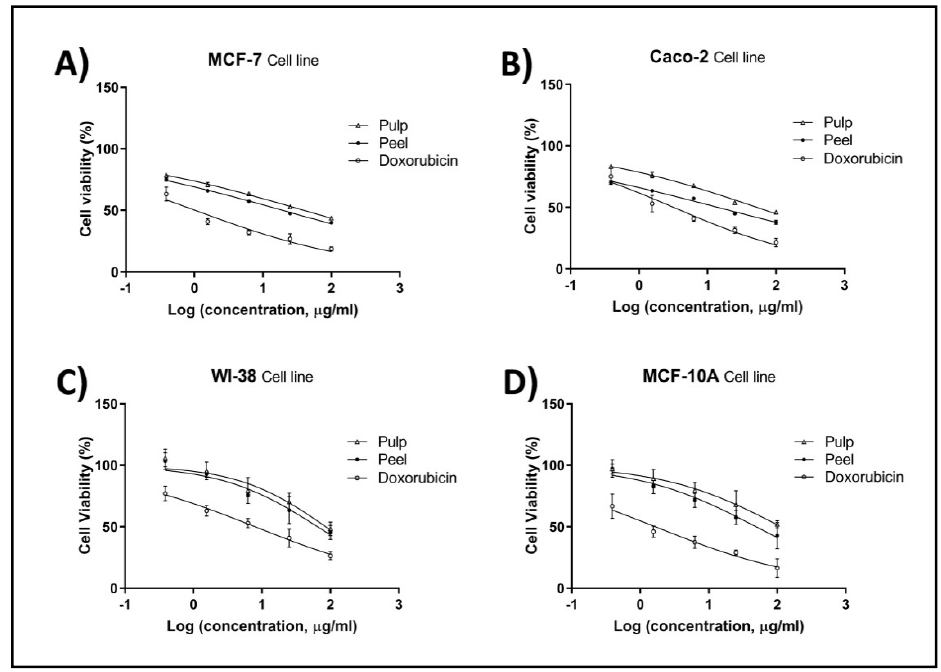
Figure 1. Effects of the pulp and peel extracts of H. undatus on the proliferation of MCF-7 ( A ), Caco-2 ( B ), WI-38 ( C ), and MCF-10A ( D ) cells. Untreated cells were used as control. Table 4. IC 50 values and selectivity index (SI) of peel and pulp H. undatus extracts against MCF-7, Caco-2, WI-38, and MCF-10A cell lines.